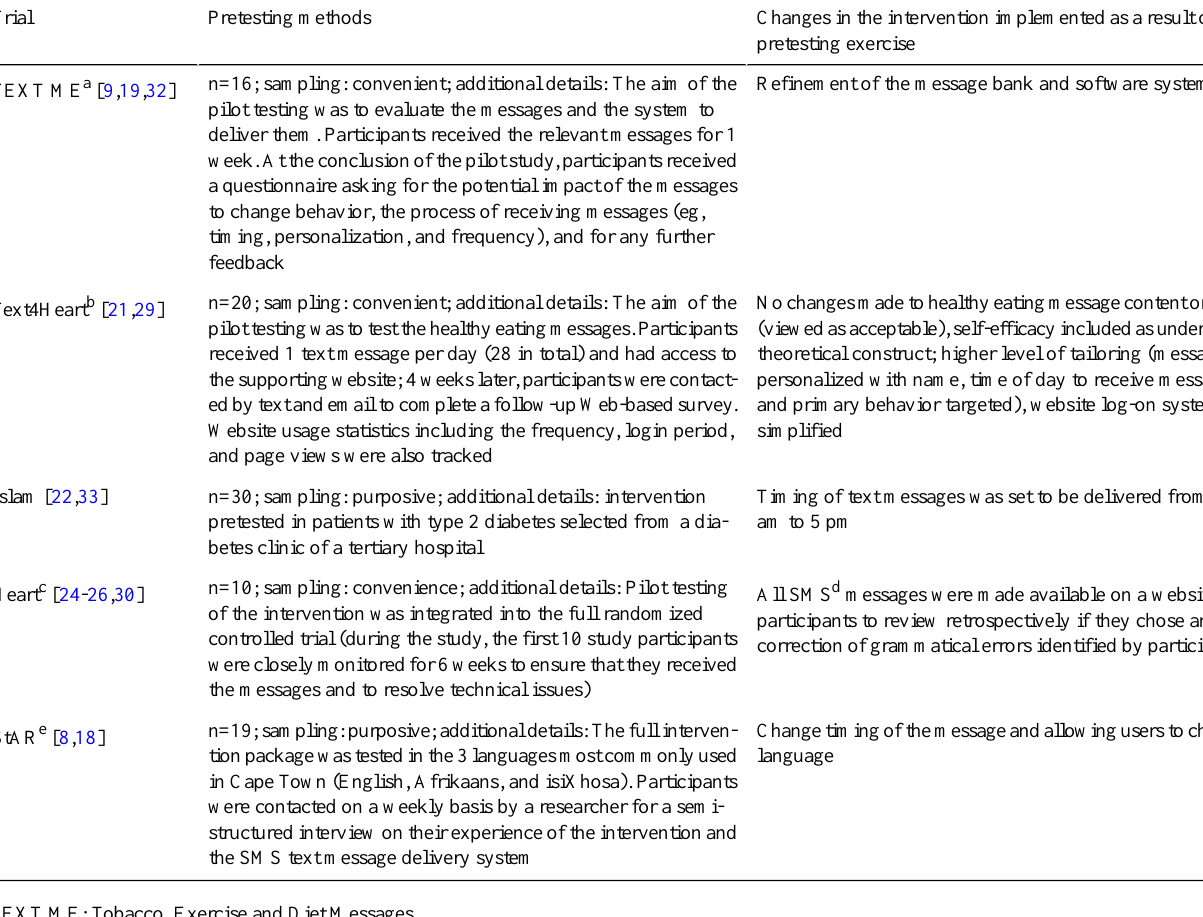
Table 4. Intervention pretesting.